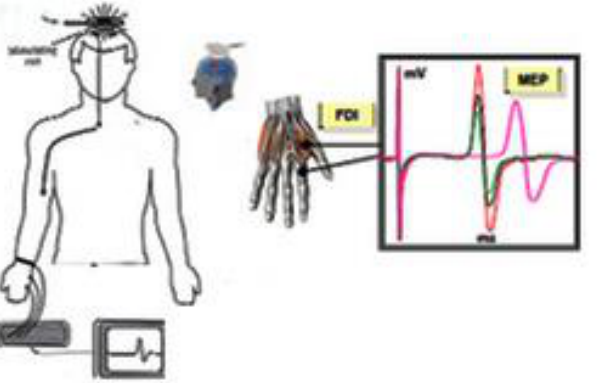
Figure 2. Motor Evoked Potential (MEP). Motor evoked potentials are the electrical signals recorded from the descending motor pathways or from muscles following stimulation of motor pathways within the brain.